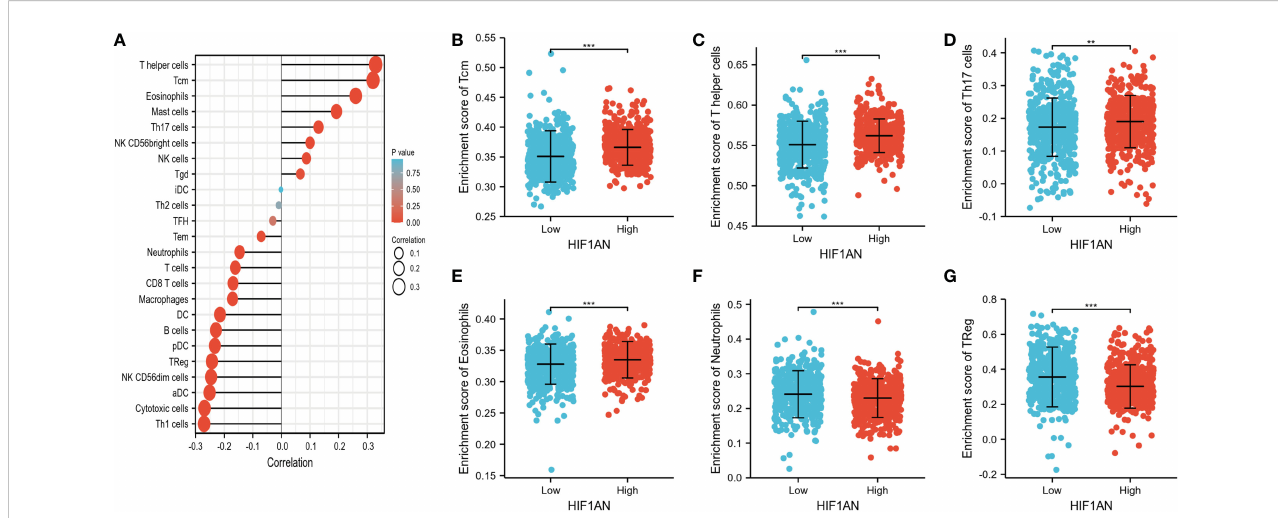
FIGURE 6 Correlation of immune cell in fi ltration and HIF1AN expression in BC females. (A) correlations among in fi ltration levels of 24 kinds of immune cell and HIF1AN expression pro fi les by Spearman ’ s evaluation test. Illustrated is the comparison of in fi ltration levels of most correlated immune cells, containing Tcm (B) , T helper cells (C) , Th17 cells (D) , Eosinophils (E) , Neutrophils (F) and Treg (G) between high and low HIF1AN expression groups. DCs, dendritic cells; aDCs, activated DCs; iDCs, immature DCs; pDCs, plasmacytoid DCs; Th, T helper cells; Th1, type 1 Th cells; Th2, type 2 Th cells; Th17, type 17 Th cells; Treg, regulatory T cells; Tgd, T gamma delta; Tcm, T central memory; Tem, T effector memory; Tfh, T follicular helper; NK, natural killer; ns: P ≥ 0.05, *P < 0.05, ** P < 0.01, and *** P <